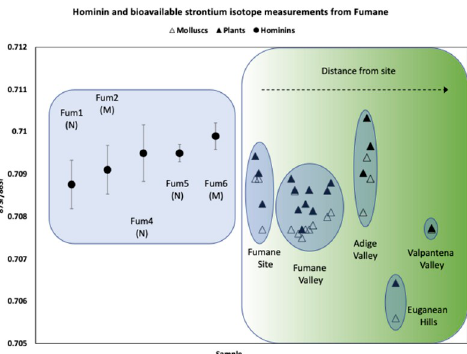
Fig 3. Strontium isotope values of hominin dental enamel and local molluscs and plants from the fumane site and surrounding regions. The plant and mollusc data is given in the Supplementary Information. The Fumane 1 and Fumane 2 values are the average of the outer and inner enamel measurements for each of the two teeth. The Fumane 4, 5 and 6 values are the average of two outer enamel measurements. Error bars on the hominins are given as 1s, and the 1s errors on plant and snail strontium measurements are much smaller, and plot within the